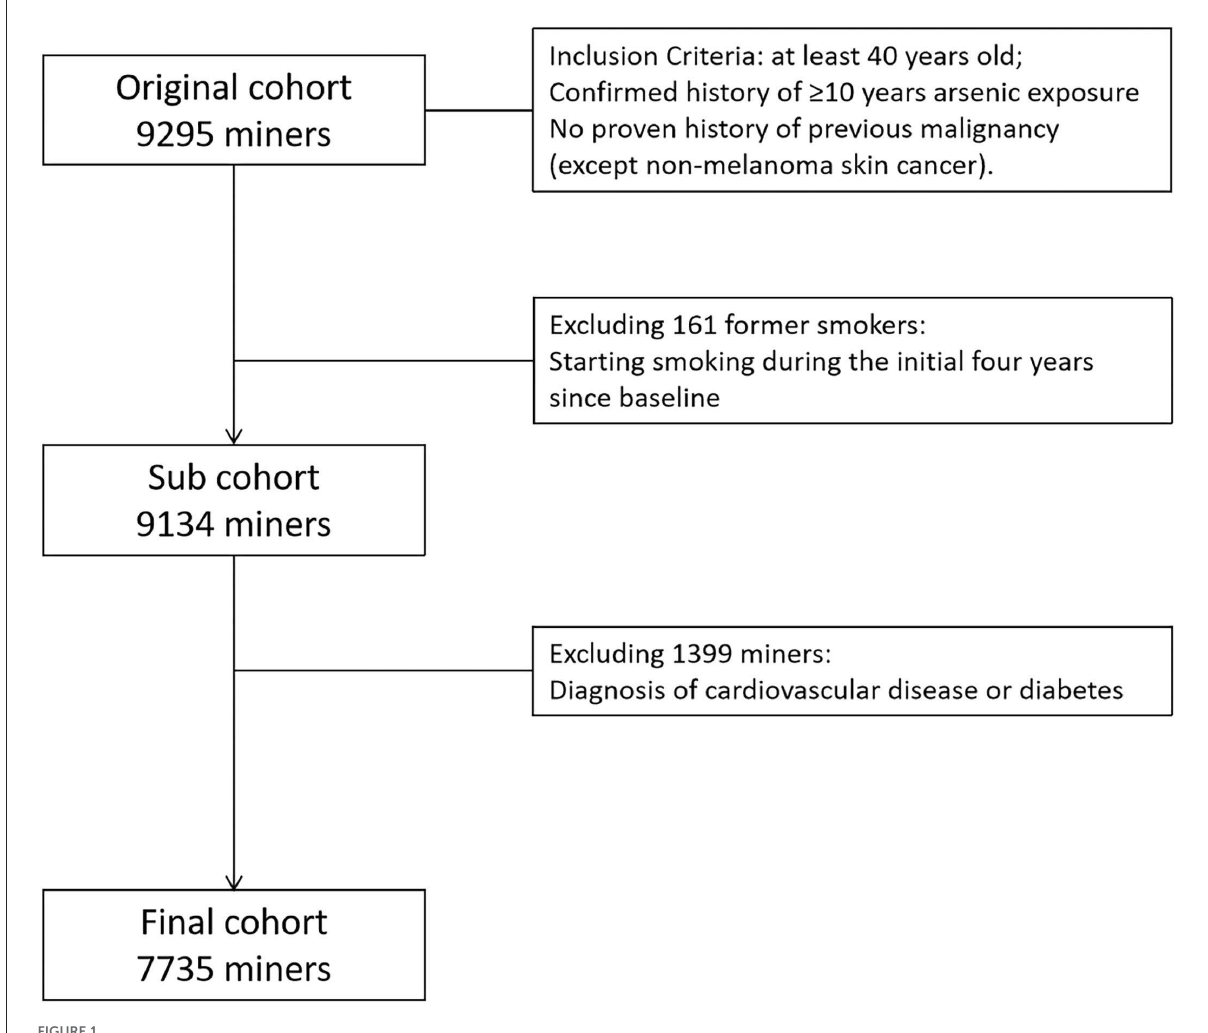
FIGURE1 Flow chart of selections of the participants included in final